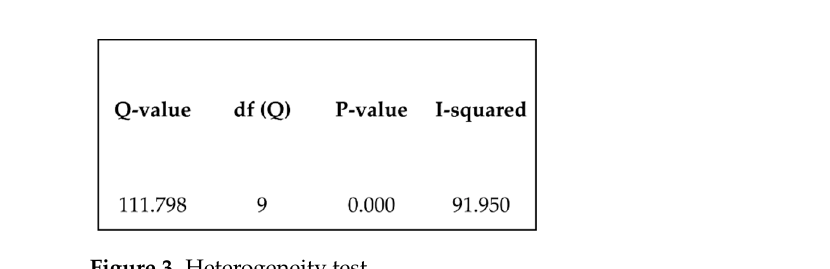
Table 5. Average values of impact strength 1